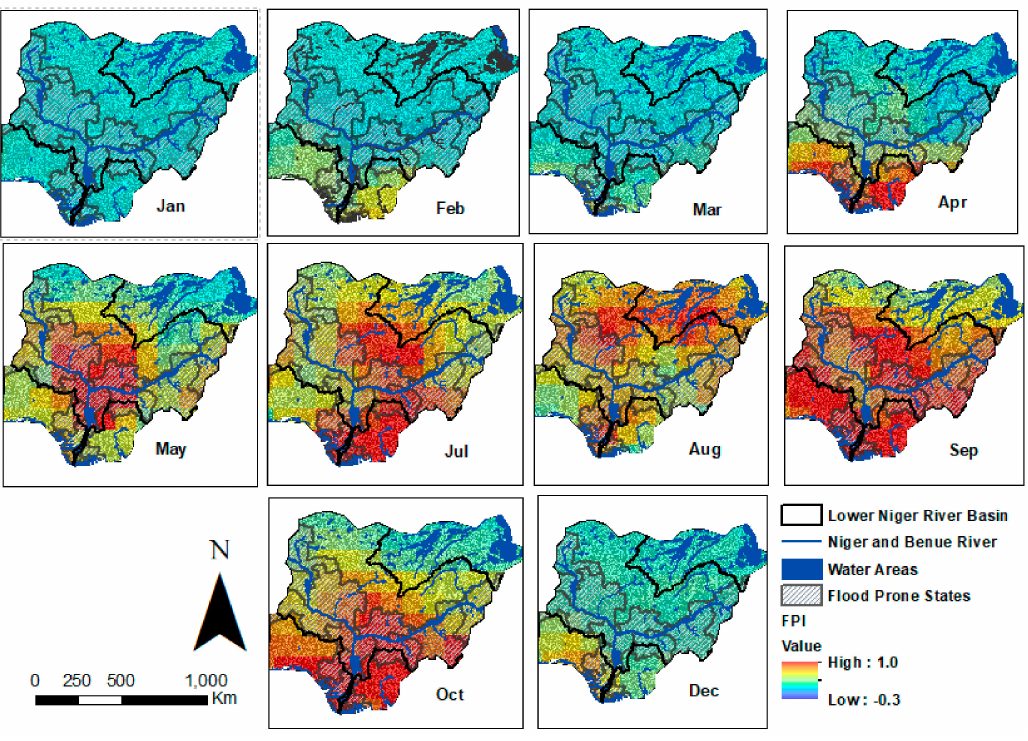
Figure 15. Spatiotemporal distribution of the flood potential index for 2012 in the LNRB. The red and blue areas indicate high and low probability or likelihood of flooding. According to the Nigerian National Emergency Management Agency (NEMA), 30 out of 36 states experienced